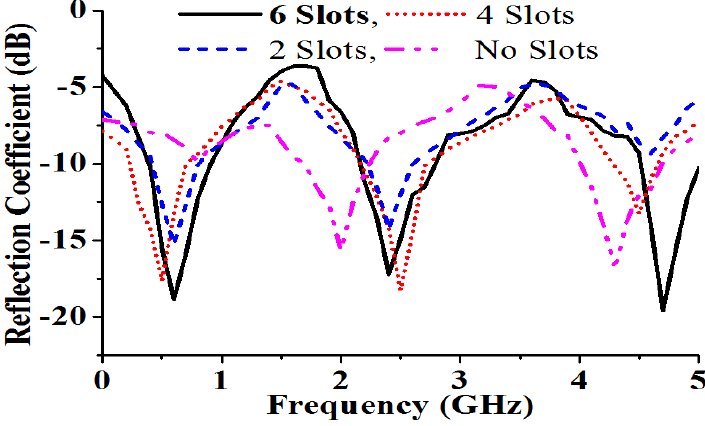
Figure 2. Effect of slot loading in the ground plane of the proposed near-zero refractive index (NZRI) MSS antenna.